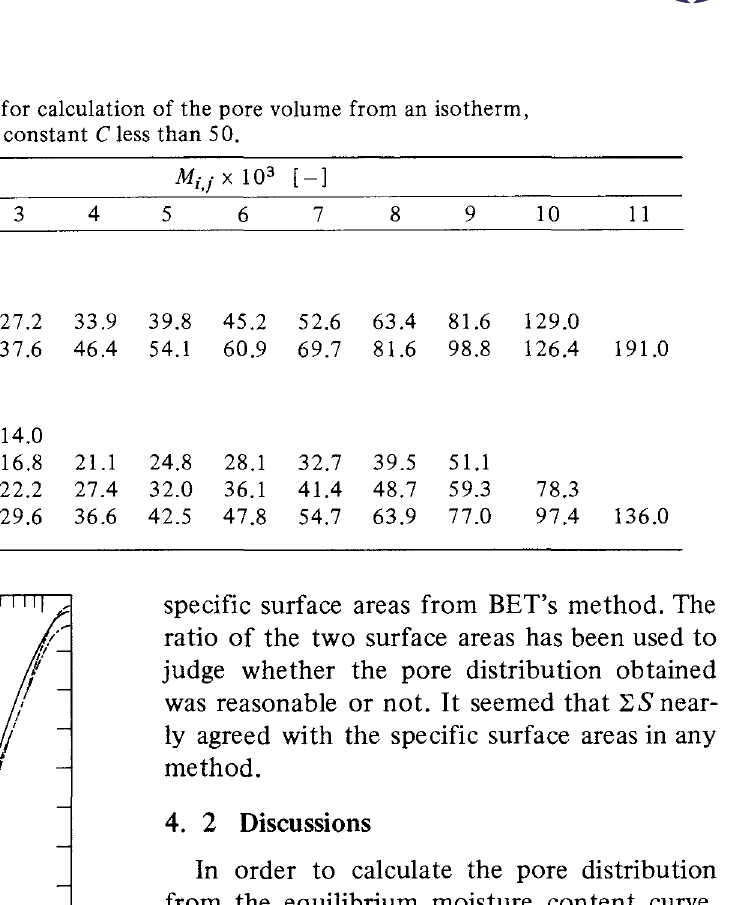
Table 4 Rc and M values for calculation of the pore volume from an isotherm, which has BET's constant C less than 50.